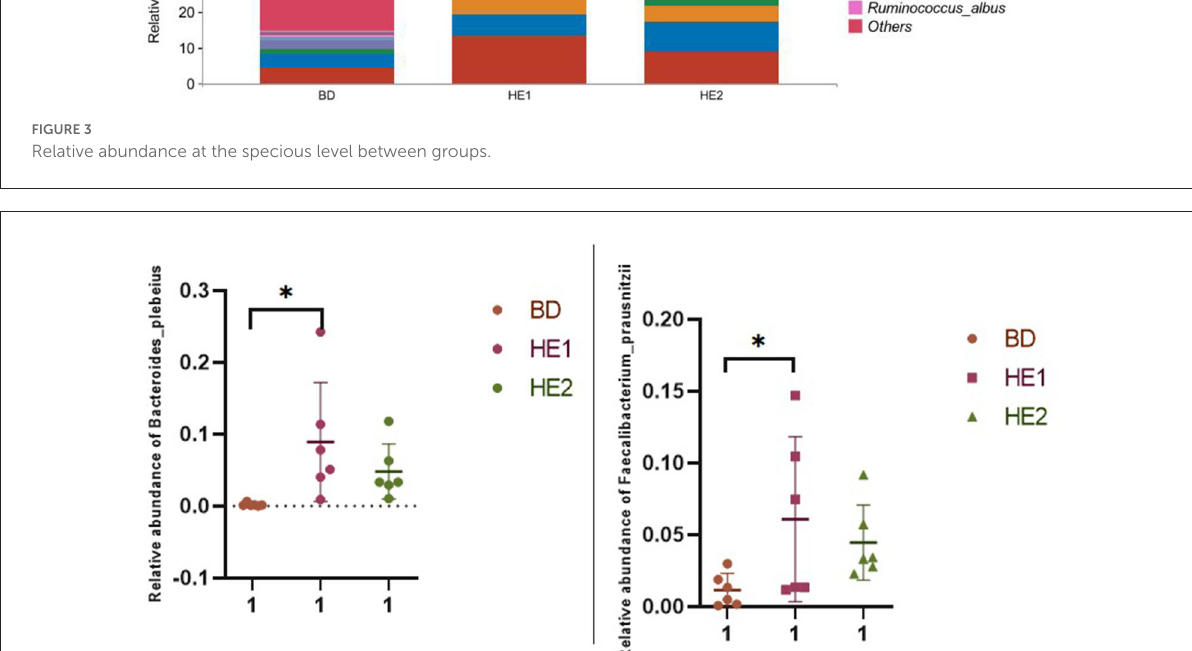
FIGURE4 Scatter plot of the relative abundance of significantly different specious in each